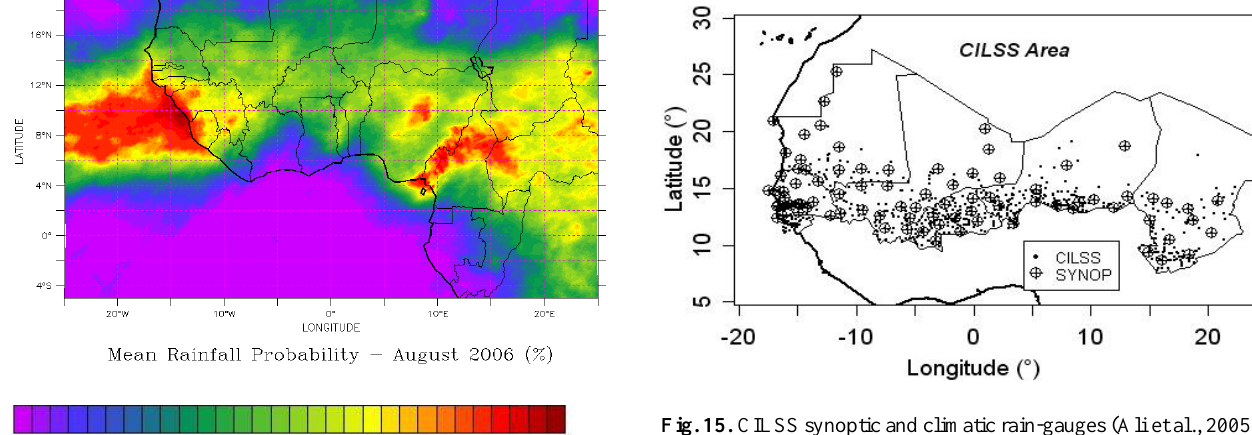
Fig. 15. CILSS synoptic and climatic rain-gauges (Ali et al., Figure 15. CILSS synoptic and climatic rain-gauges (Ali et al., 2005)